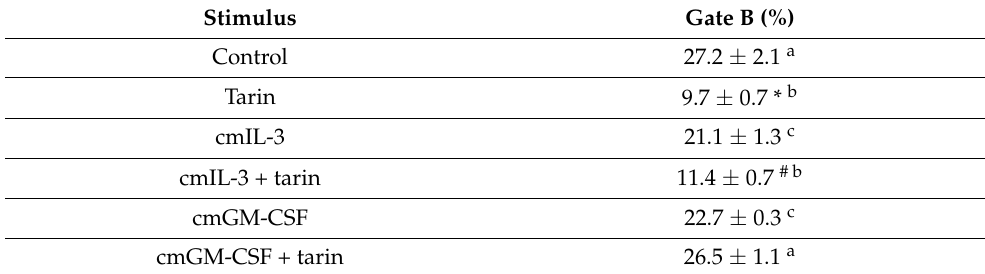
Values indicate the percentage of IL-7R α + bone marrow cells in gates A or B after 5 days of treatment or not with tarin at 25 µ g/mL and/or 10% ( v/v ) conditioned medium highly enriched with IL-3 (cmIL-3) or GM-CSF (cmGM-CSF). Values are expressed as the means ± SD of three independent experiments carried out in